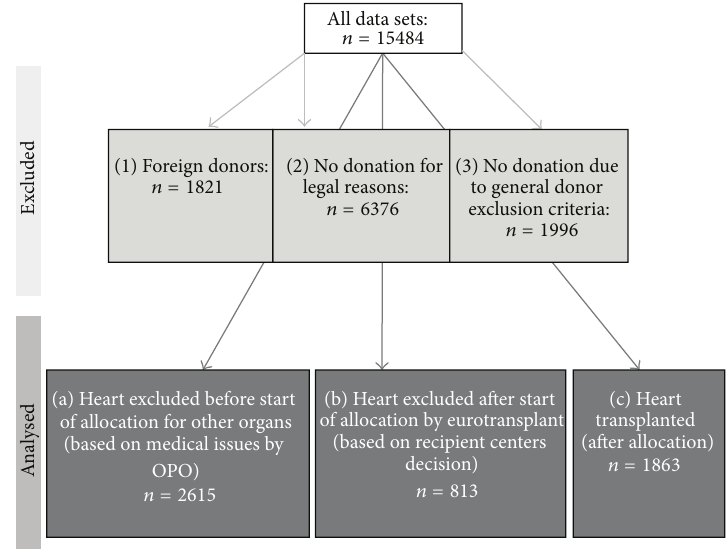
Figure 1: Flow chart of the analysed DSO data records from the years